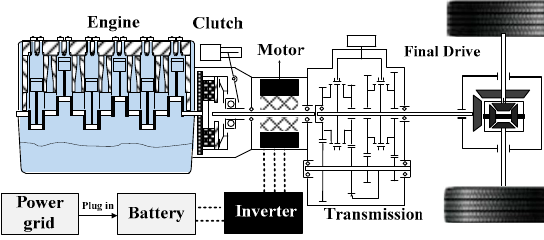
Figure 1. The configuration of the plug-in hybrid electric bus (PHEB).